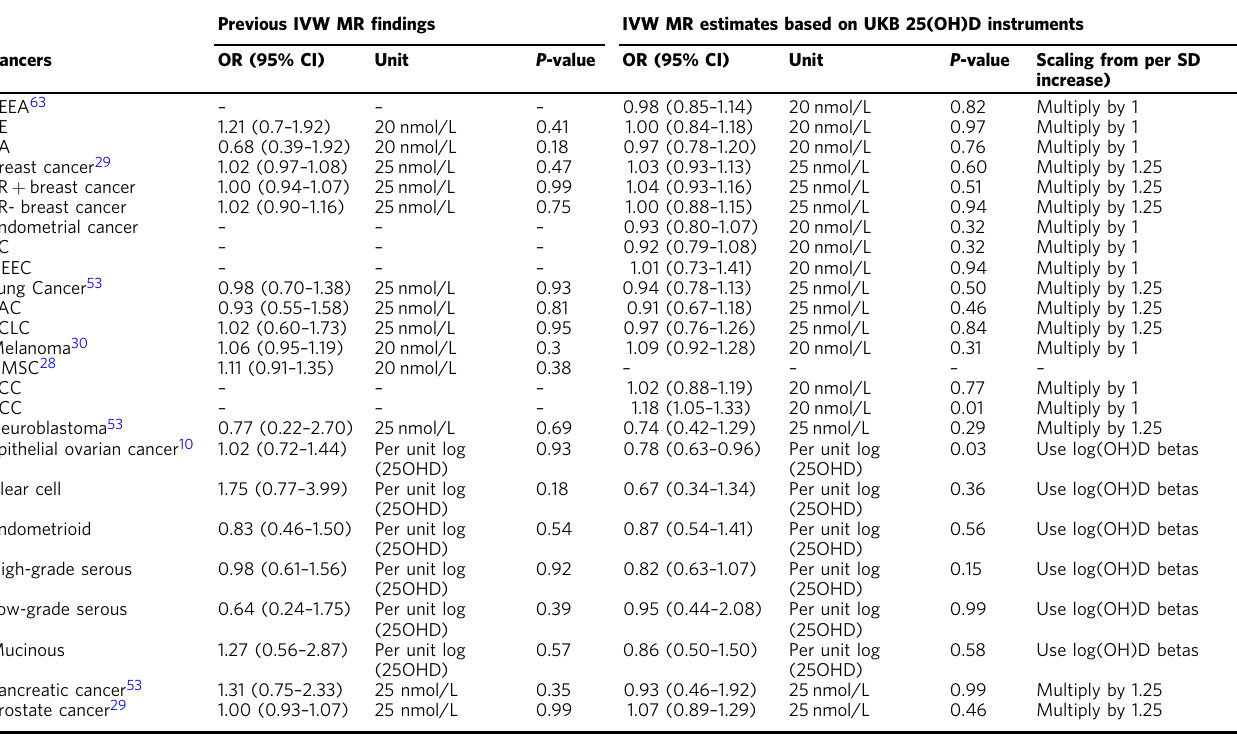
Table 3 Comparison of revised MR estimates on 25(OH)D and cancer risk against previous fi